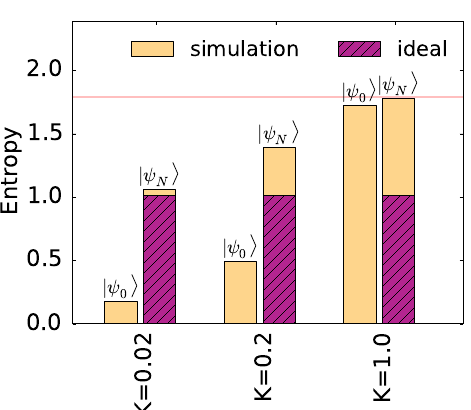
Figure 6: The von Neumann entropy S ( t = 2500 ) extracted from Fig. 5 (indicated by sim- ulation) compared to entropy for the mixed-state that corresponds to pure dephasing in the energy eigenbasis (marked by ideal). The simulations have been carried out for a central- = 4 particles weakly coupled ( I = 0.25 J system of N ) to N (cid:69) = 16 environment particles via S S random antiferromagnetic Ising coupling. The initial state of the CS and the intra-environment 〉 is zero. strength (in units of J ) are indicated in the panel. The ideal entropy for state | ψ S 0